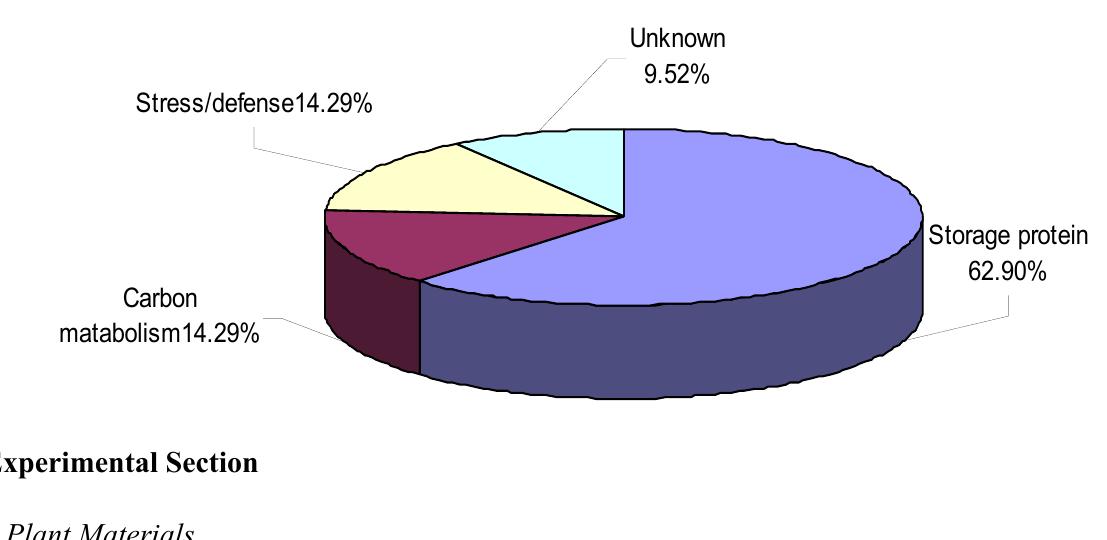
Figure 6. Functional distribution of 21 differentially expressed seed proteins between CS and 3BS-8.